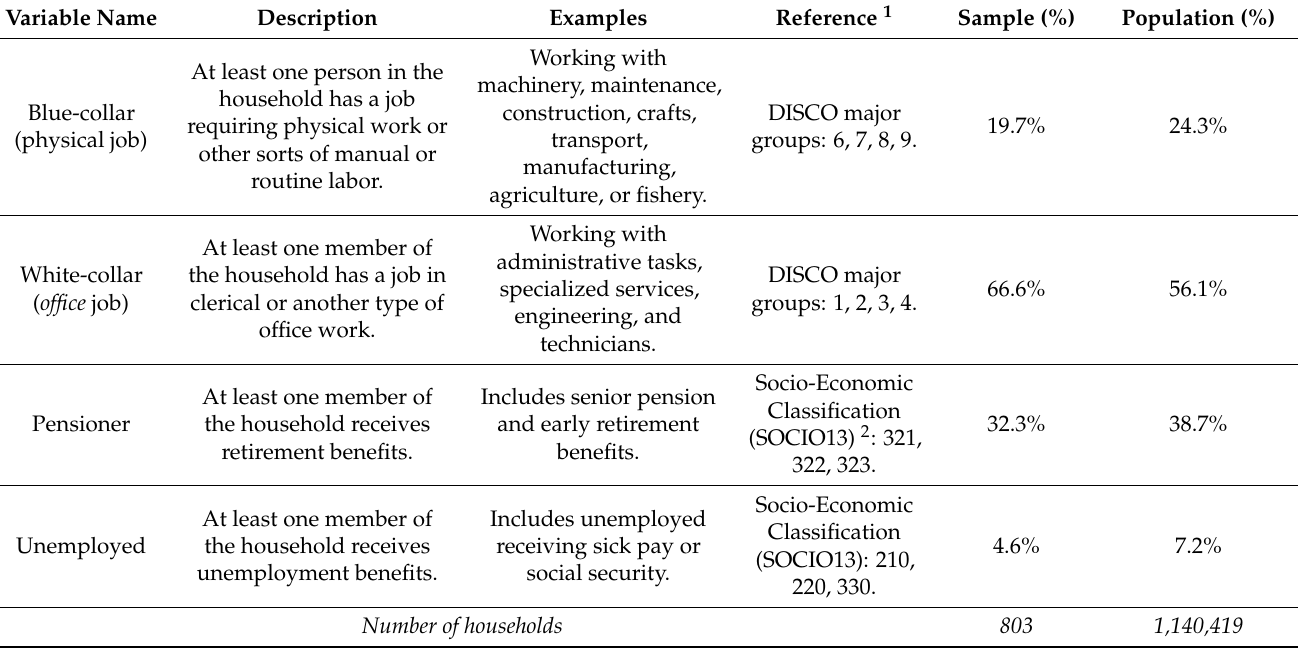
Table 1. Presentation and description of occupational variables with share (%) of the total sample. Each household can have several characteristics, so the percentages do not sum to